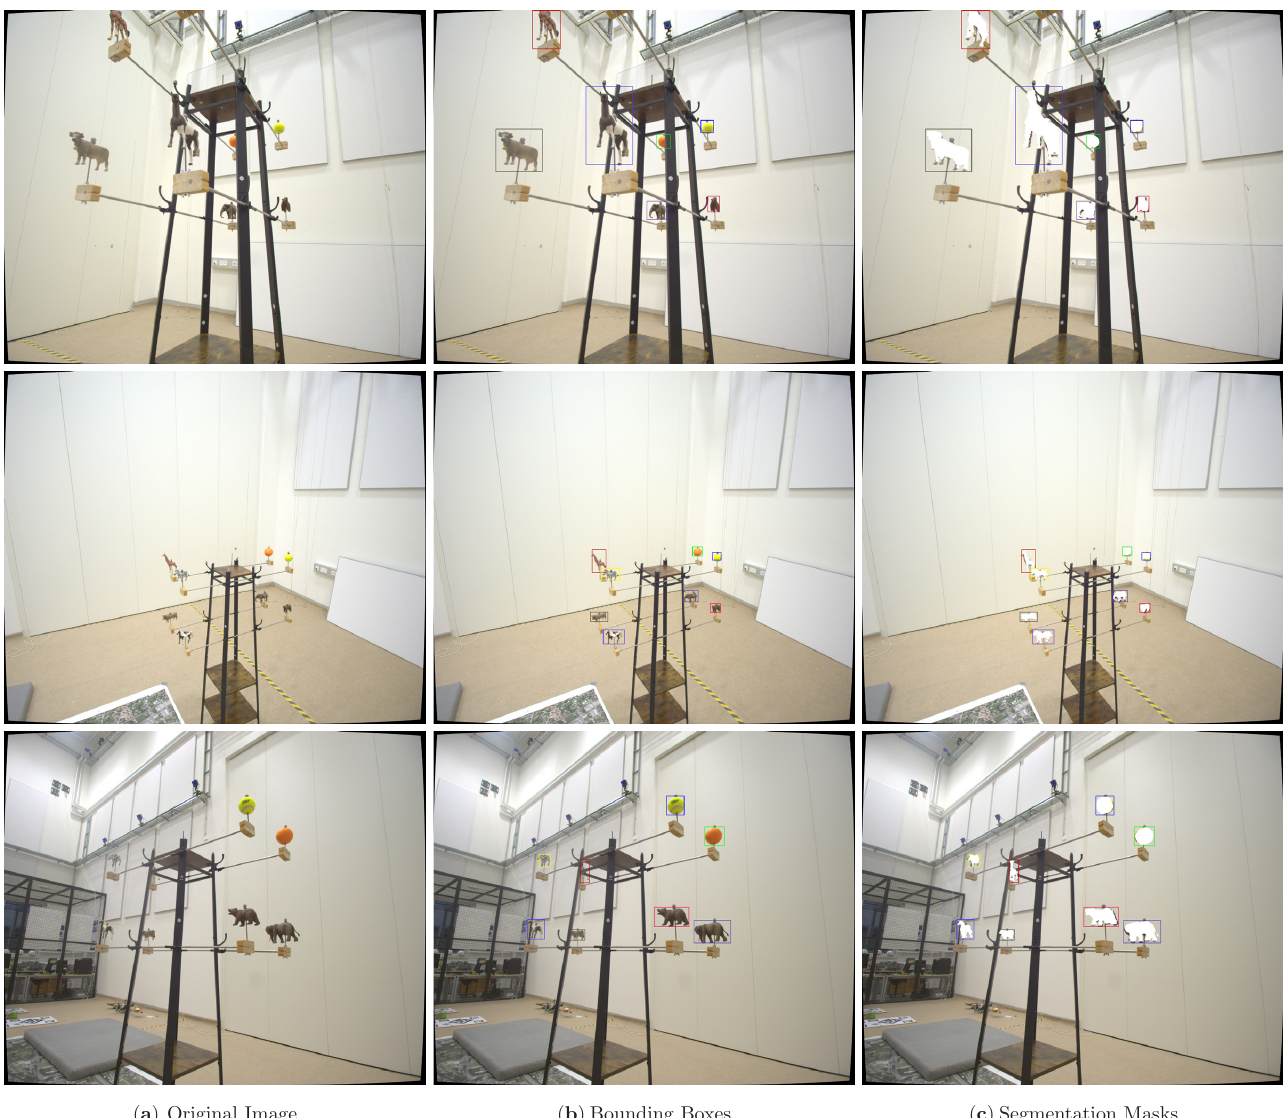
Figure 6. Annotation results produced by our pipeline for the toy example from three different angles. The first column shows the original image, while the second column illustrates the annotated bounding box for each object present in the image. Similarly, the third column displays the corresponding binary masks. The images clearly show that our pipeline is able to produce high-quality annotations sufficient for training and evaluating AI-based algorithms for object detection, instance segmentation, and 6-DoF pose estimation. Only for binary segmentation masks is the annotation not perfect due to the 3D-models not capturing well enough fine details such as the animals’ legs. Best viewed as PDF and in